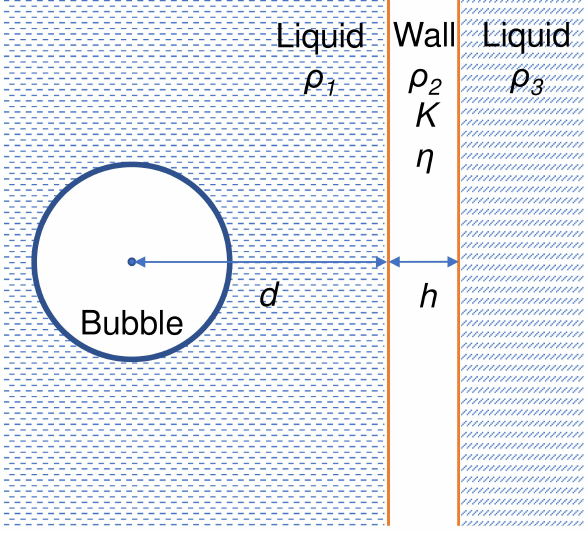
Figure 6. Schematic of a spherical bubble near an elastic